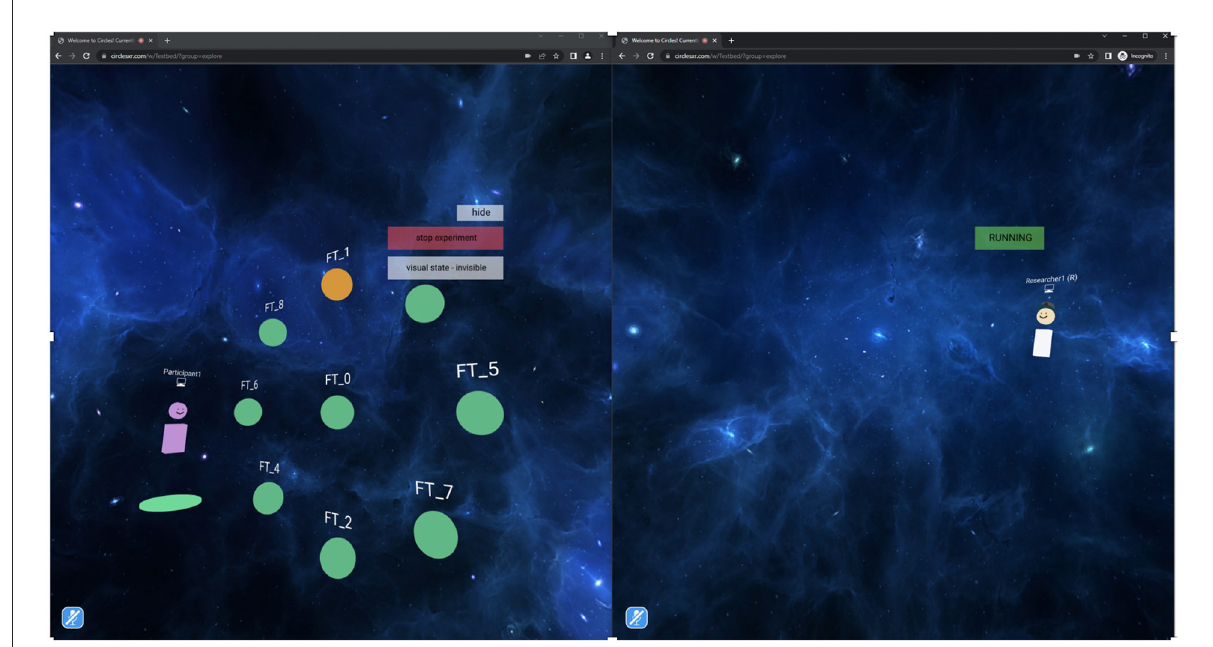
FIGURE3 The Circles framework’s “Research Room” running on Google Chrome (Desktop) showing that participants log into a WebXR website (right) and select targets under the supervision of the researcher